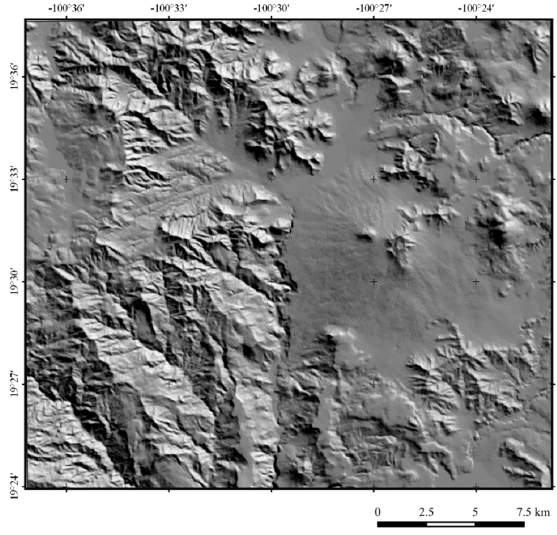
Figure 3 . Shadowed Digital Elevation Model.